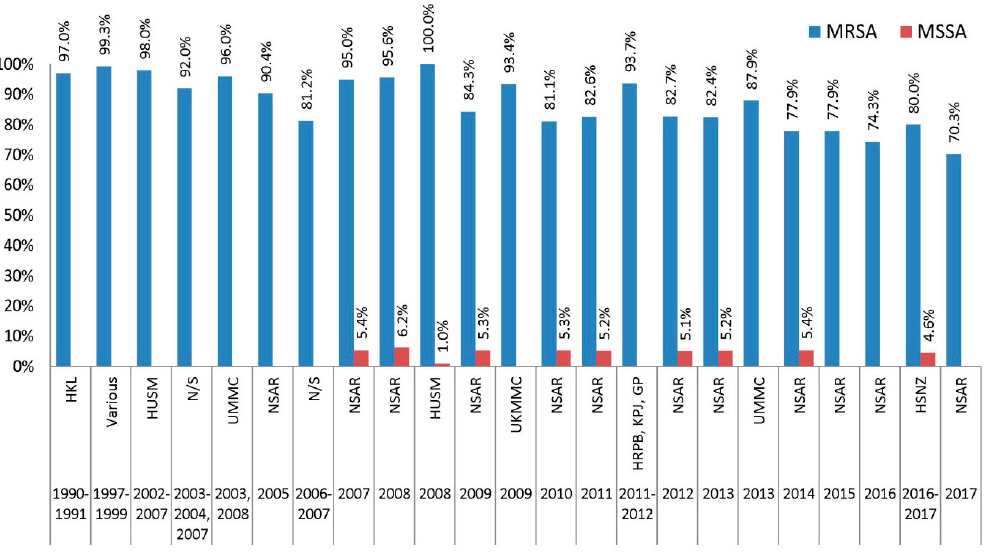
Figure 3. The prevalence of erythromycin resistance among Malaysian S. aureus isolates, 1990–2017. Data from the NSAR reports; HKL between 1990 and 1991 [13]; Various, collected from ten hospitals throughout Malaysia between 1997 and 1999 [14]; HUSM between 2002 and 2007 [15] and in 2008 [19]; not specified (N / S) between 2003 and 2004 and in 2007 [16], and between 2006 and 2007 [17]; UMMC in 2003 and 2008 [18], and in 2013 [22]; UKMMC in 2009 [20]; HRPB, KPJ and GP between 2011 and 2012 [21]; and HSNZ between 2016 and 2017